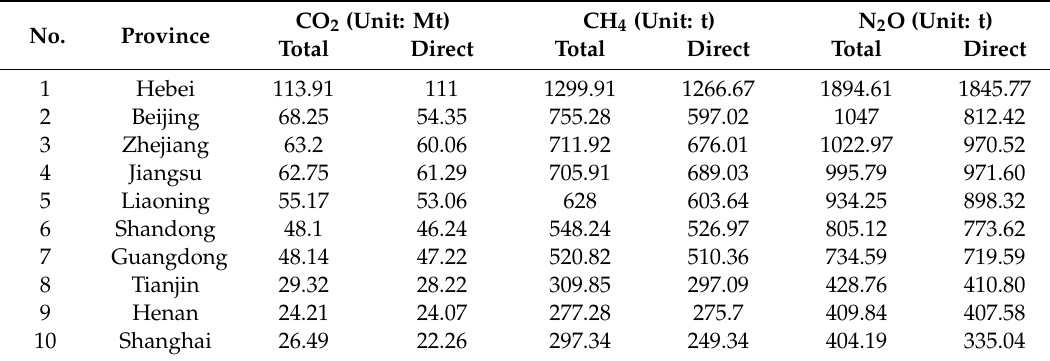
Table 1. Major emission exported provinces.